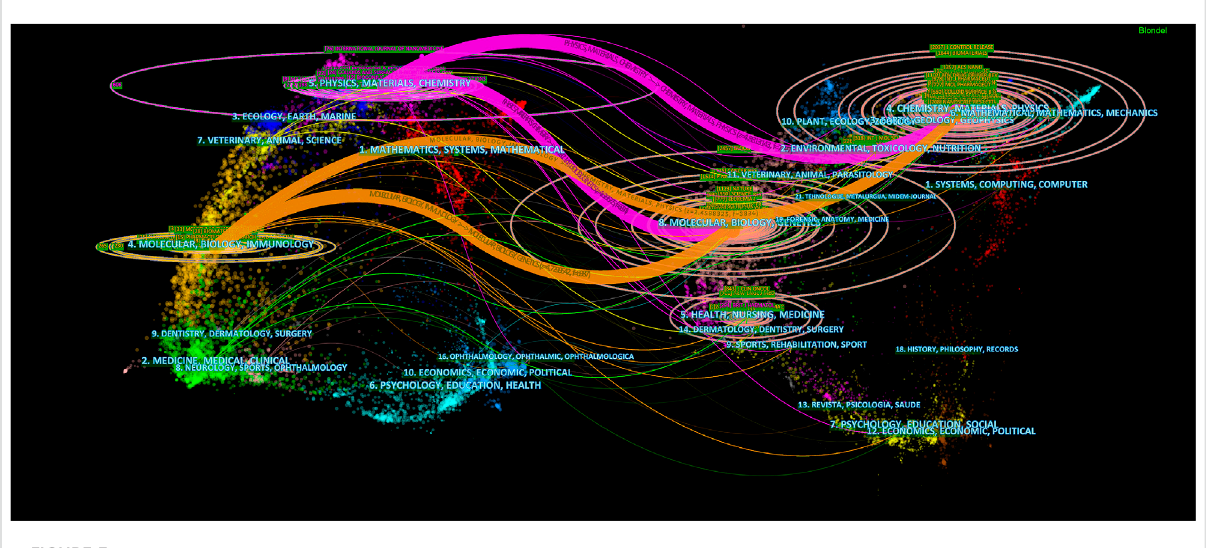
FIGURE 3 The dual-map overlay of journals related to Nanoparticles-leukemia research. Notes: The citing journals were on the left, the cited journals were on the right, and the colored path represents the citation